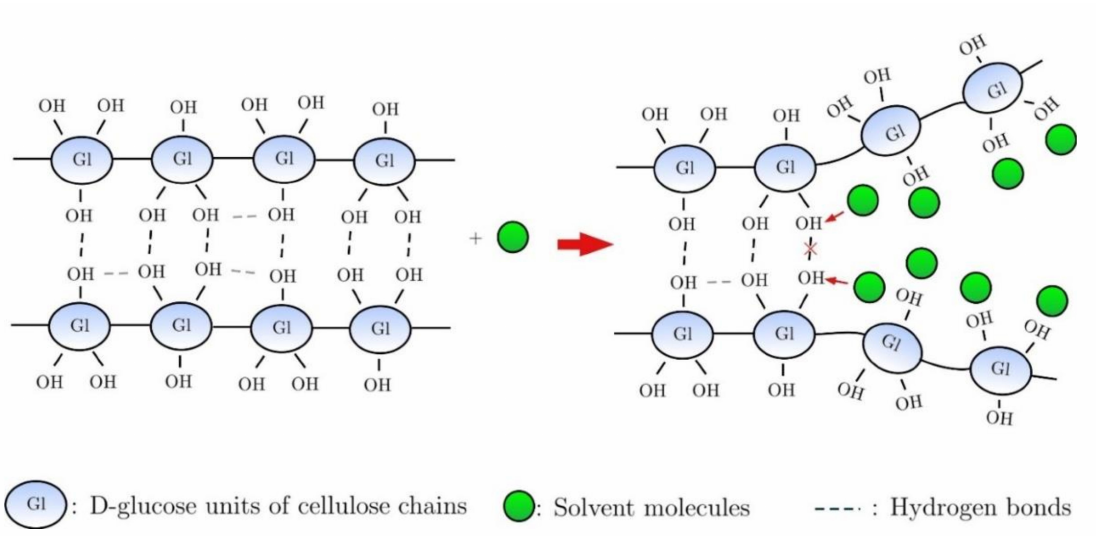
Figure 2. Schematic of cellulose